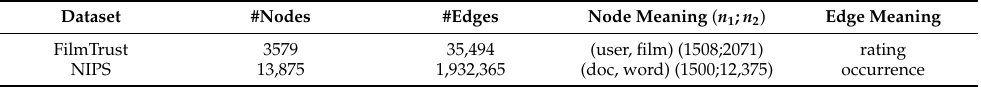
Table 3. Statistics of datasets. All datasets have the type of bipartite and undirected.